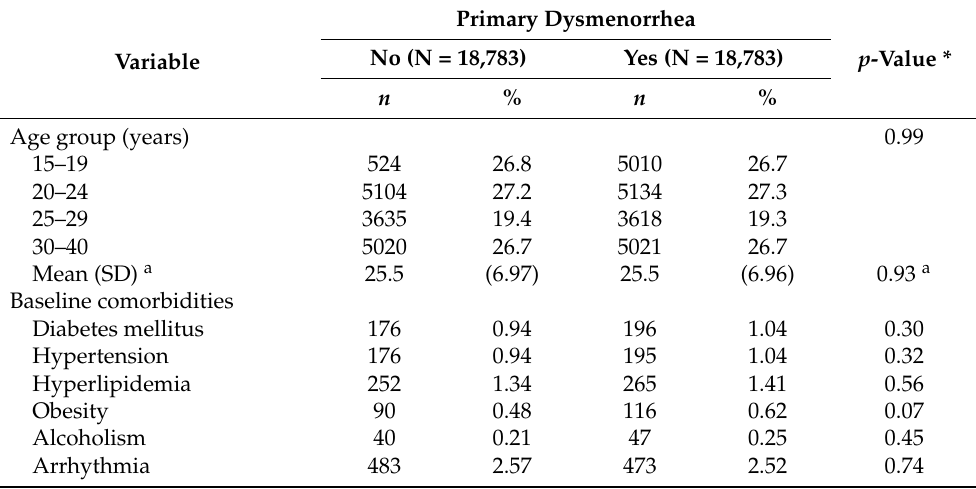
Table 1. Distributions of age, comorbidities, and NSAID use compared between cohorts with and without primary